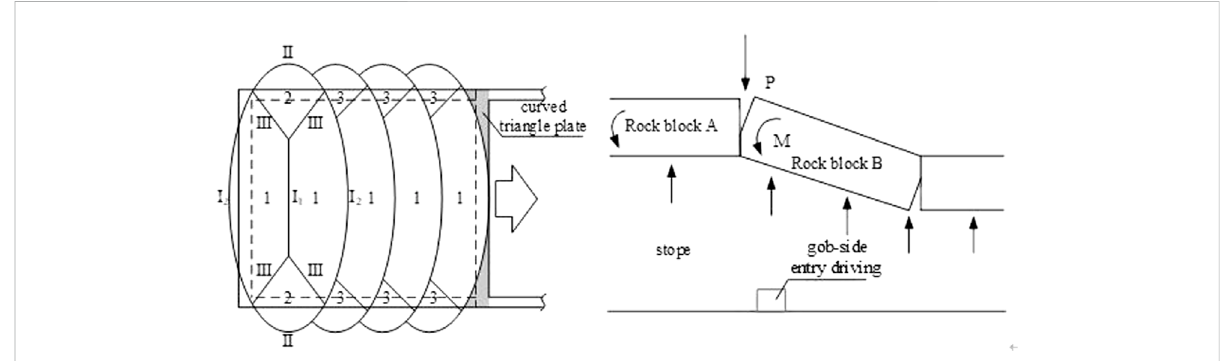
FIGURE 3 Breaking characteristics of the basic top structure.